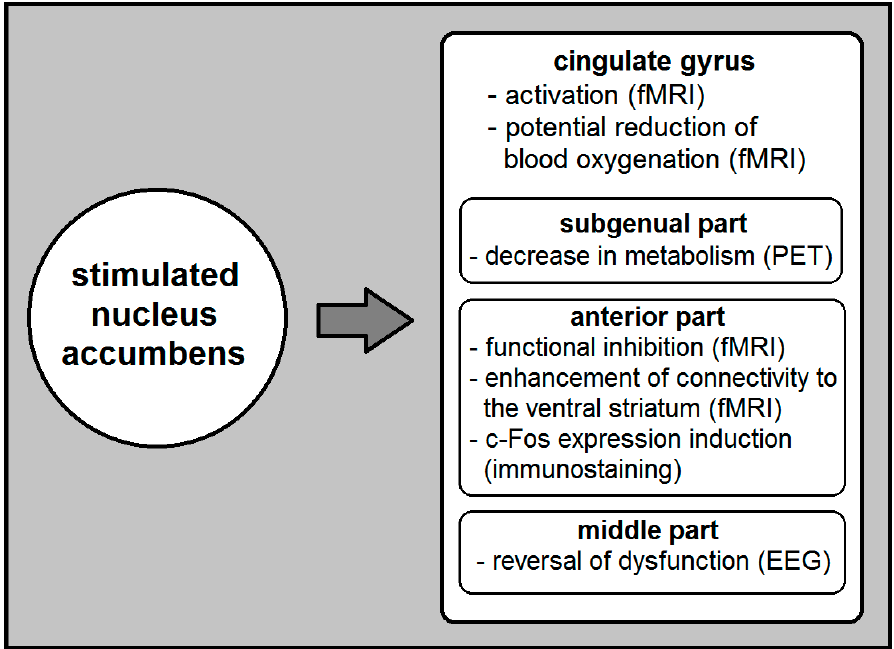
Figure 1. A simplified summary of the currently known effects of nucleus accumbens (NA) deep brain stimulation (DBS) on the cingulate gyrus (CG). The investigating method used to identify these effects appears in parentheses. EEG, electroencephalogram; fMRI, functional magnetic resonance imaging; PET, positron emission tomography.